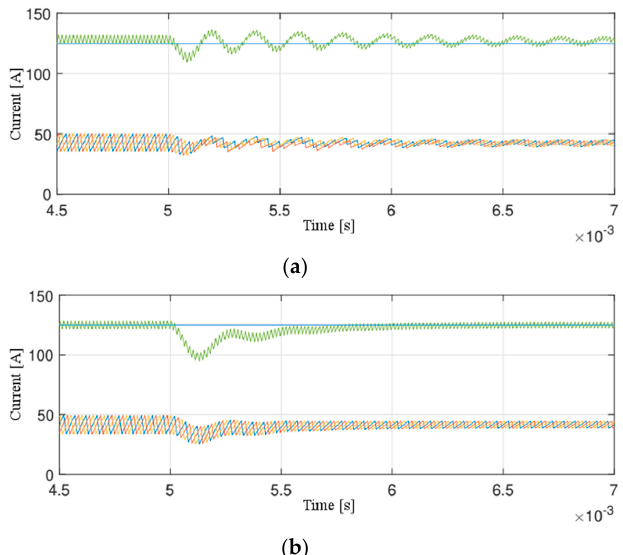
Figure 12. Total (green), reference (light blue), and inductors (blue, yellow, and red) currents under 20% output load variation with the method proposed in [13] ( a ) and with the method proposed in this paper ( b ).